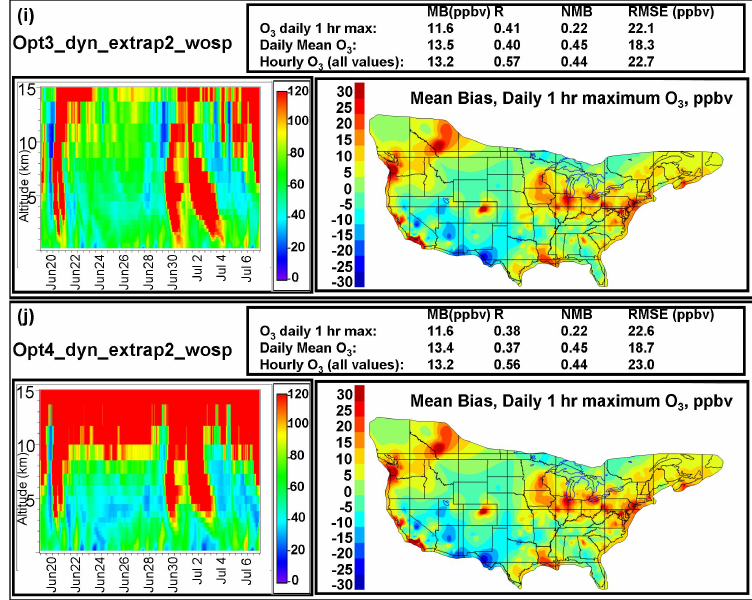
Fig. 5. (i) and (j) As in (a) and (b), but for Opt3 dyn extrap2 wosp and Opt4 dyn extrap2 wosp methodologies.